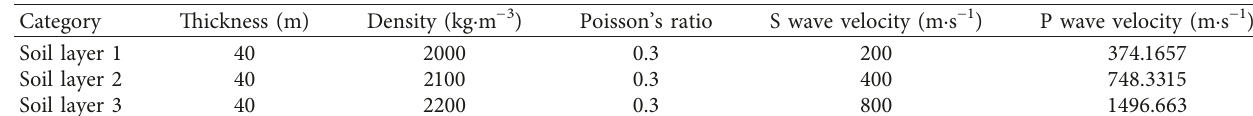
Table 1: Soil layer parameters.